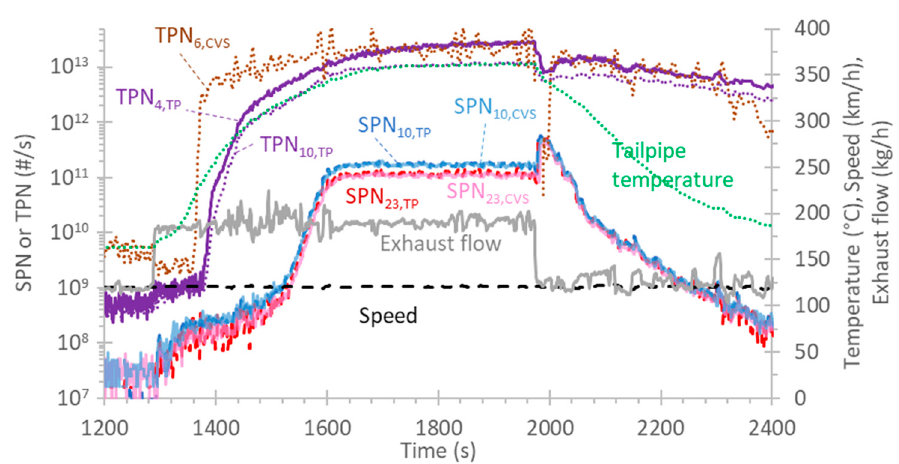
Figure 4. Emissions during the last regeneration event of vehicle #1 (Euro 6d-Temp) at 120 km/h. The solid particles started increasing at approximately 1500 s (exhaust gas